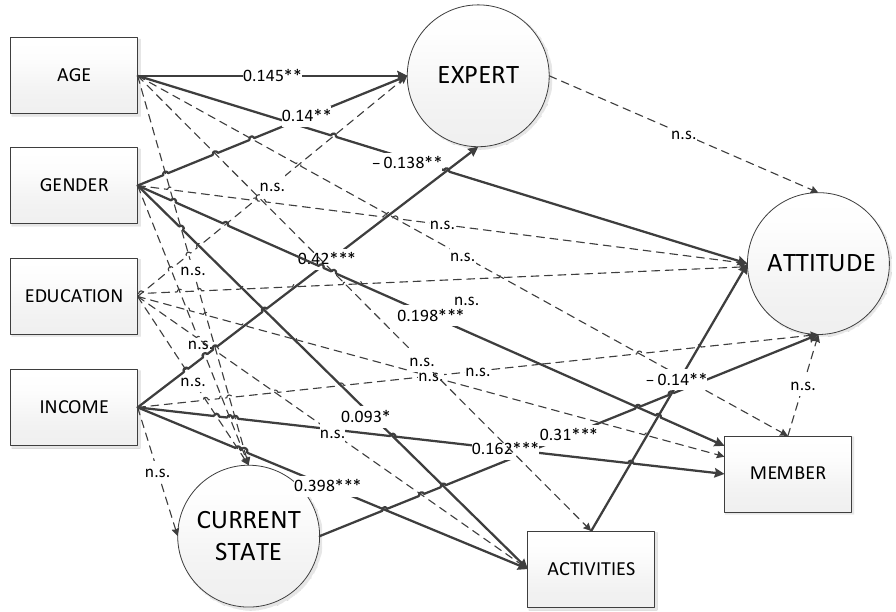
Figure 6. Estimated parameters along with corresponding statistical significance (Model E). * parameter is significant at the 10% significance level. ** parameter is significant at the 5% significance level. *** parameter is significant at the 1% significance level. n.s.: non-significant.